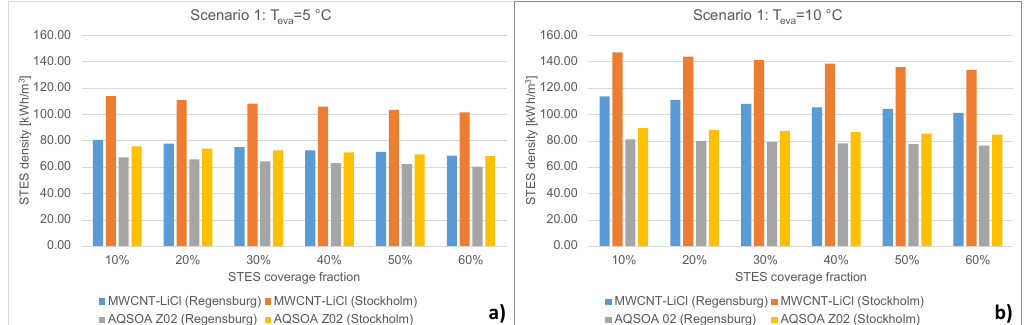
Figure 9. STES energy density calculated for Scenario 1 with evaporation temperature set at 5 °C ( a ) and Scenario 1 with evaporation temperature set at 10 °C ( b ), for the identified working pairs (i.e., multi-wall carbon nanotubes (MWCNT)-LiCl/water and AQSOA 02/water), both in Regensburg and Stockholm.